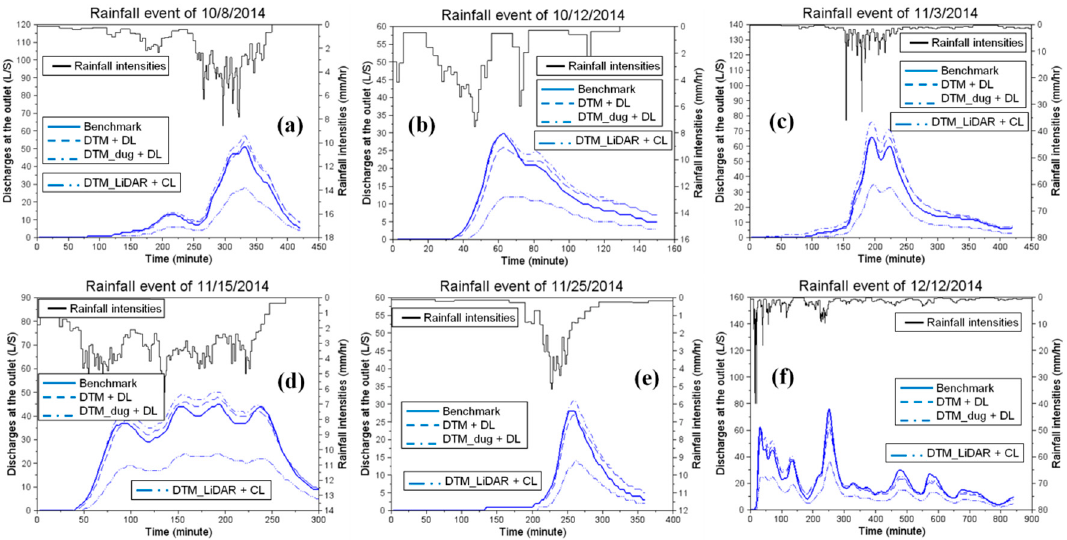
Figure 7. Sensitivity to low-resolution topographic data and coarse land-use information (free access). Simulations using DTM + LiDAR topography and detailed Land-use (reference, solid blue lines) are compared with simulations using (i) DTM topography and detailed land-use (DTM + DL, dashed blue lines); (ii) DTM—dug road topography and detailed land-use (DTM_dug + DL, dash-dotted blue lines); and (iii) DTM + LiDAR topography and coarse land-use (DTM_LiDAR + CL, dotted blue lines). Rainfall is plotted on the upper part. For events ( a ) 8 October 2014; ( b ) 12 October 2014; ( c ) 3 November